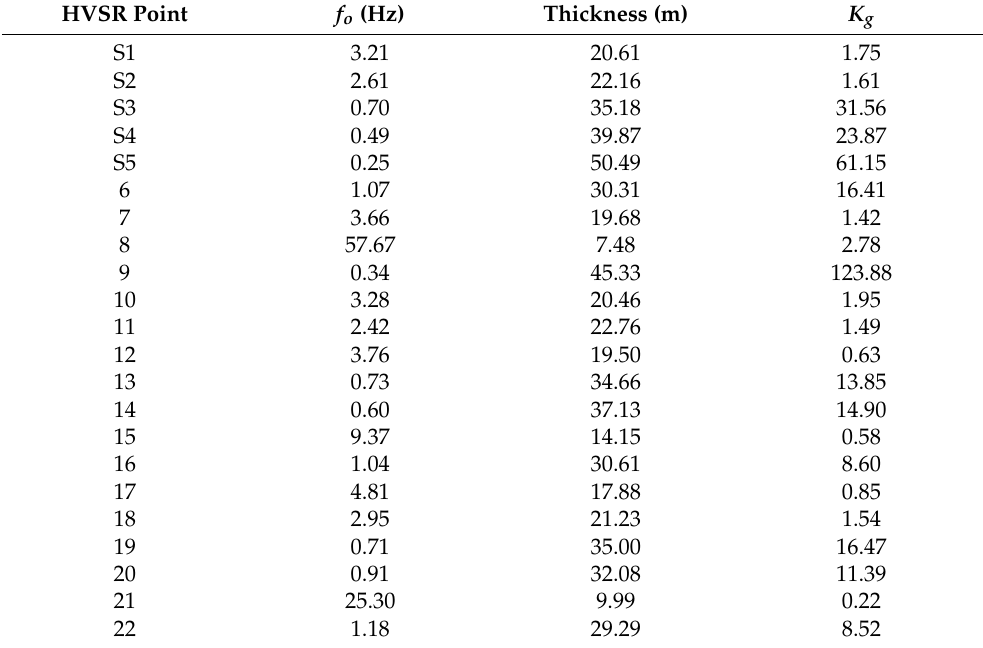
Table 4. Results obtained for sediment thickness for all HVSR test points from Equation (3), and K g dimensionless values (using Table 4 values in Equation (2)). HVSR Point f o